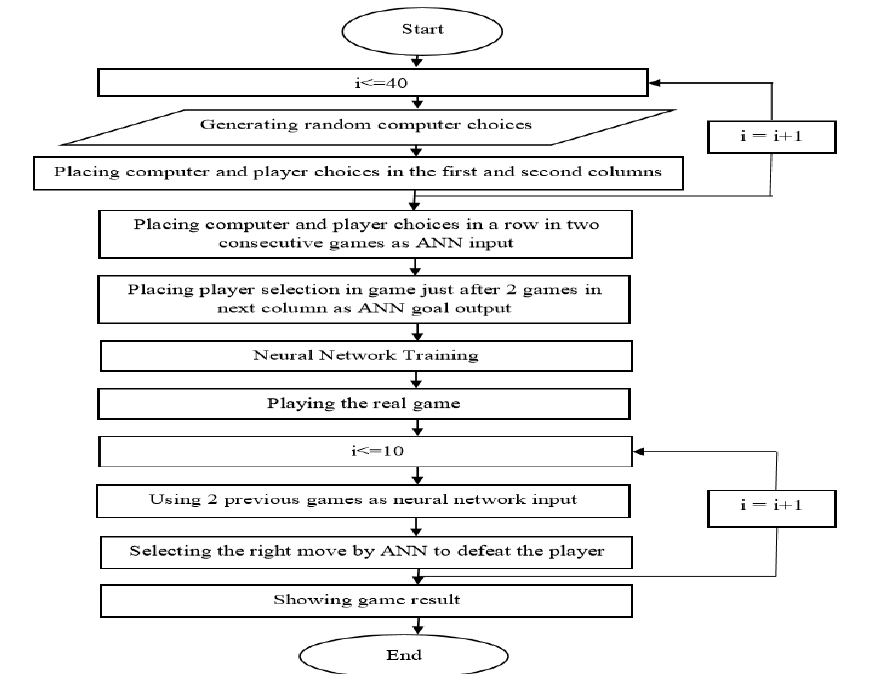
Fig. 3. Flowchart of rock, paper, scissors game designed with the neural